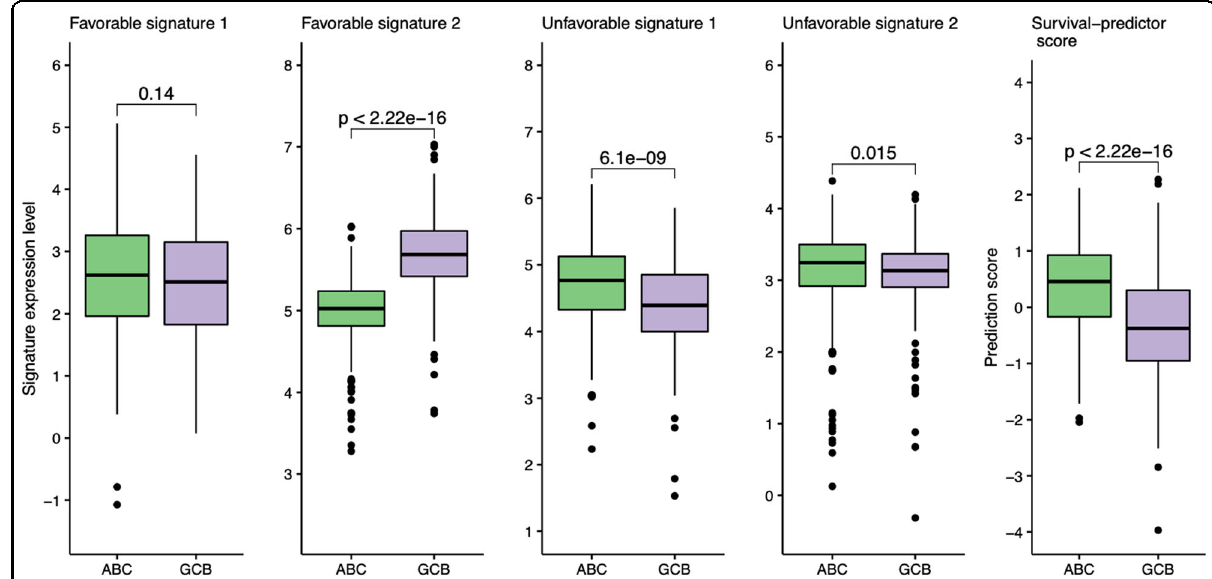
Fig. 6 Gene Expression Levels of the Survival-prediction model. The level of expression of gene signatures in the survival-prediction model and the predictor scores in ABC and GCB.